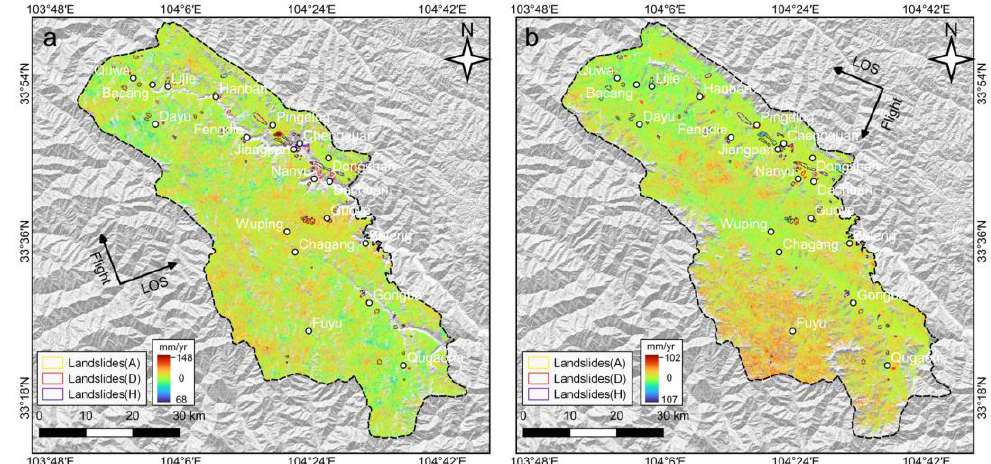
Figure 12. Deformation rate results ( V LOS ): ( a ) ascending SAR data deformation results and ( b ) descending SAR data deformation results.